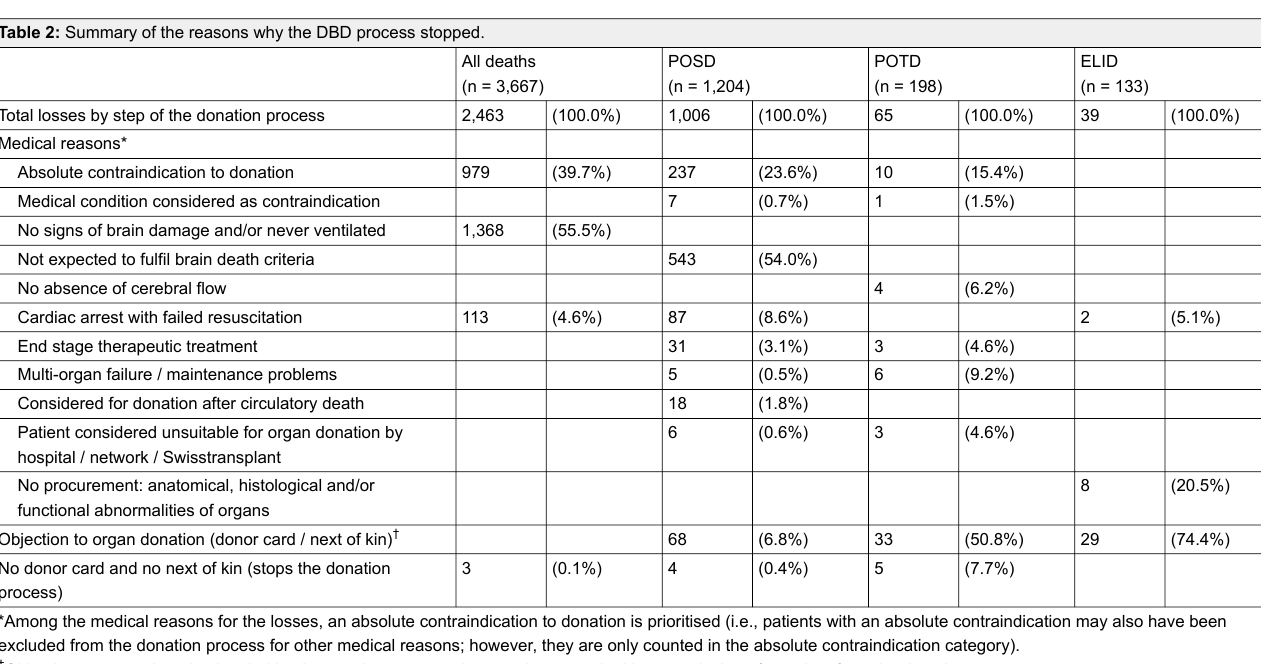
Table 2: Summary of the reasons why the DBD process